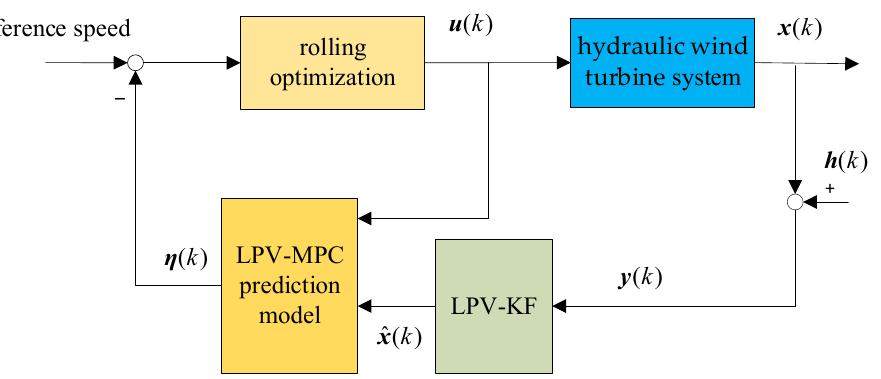
Figure 2. Structure of the LPV-MPC with the KF method for the hydraulic wind turbine. Equation (27) was discretized using the forward Euler method with a sampling time